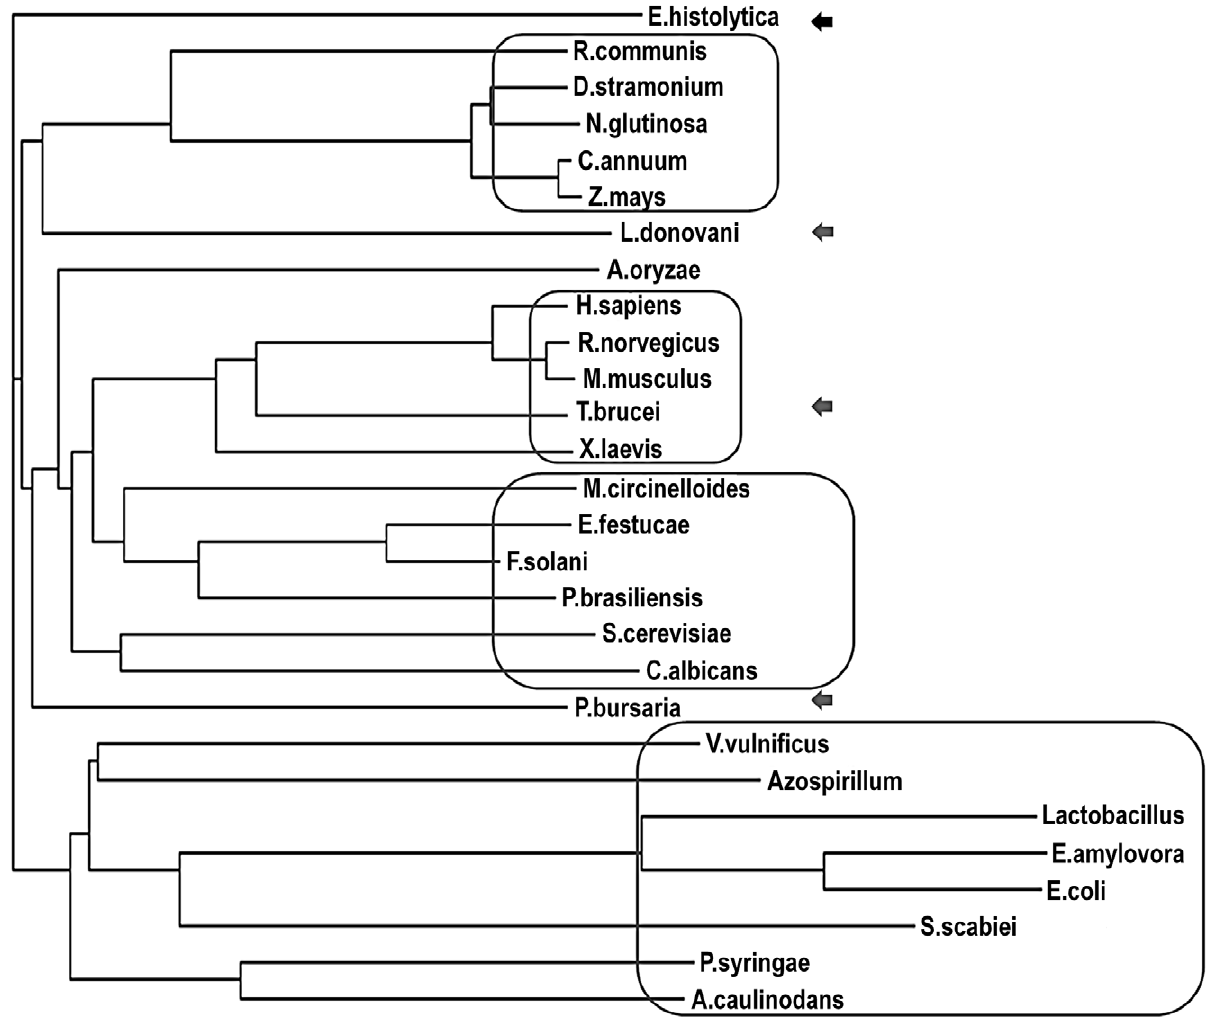
Figure 3. Phylogeny of ornithine decarboxylase from various sources. The amino acid sequences of ODC were taken from plants R. communis (XP_002510610.1), N. glutinosa (AAG45222.1), C. annum (AAL83709.1), Z. mays (AAM92262.1), D. stramonium (P50134.1); animals X. laevis (NP_001079692.1), R. norvegicus (NP_036747.1), M. musculus (P00860.2), H. sapiens (P11926.2); fungi A. oryzae (XP_001825149.2) M. circinelloides (CAB61758.1), E. festucae (ABM55741.1), P. brasiliensis (AAF34583.1), S. cerevisiae (EDN60096.1) F. solani (ABC47117.1), C. albicans (AAC49877.1); protozoa P. bursaria (NP_048554.1), T. brucei (P07805.2), L. donovani (P27116.1), E. histolytica (AAX35675) and bacteria V. vulnificus (YP_004188159.1), A. caulinodans (YP_001523249.1), P. syringae (AAO58018.1), E. amylovora (YP_003539917.1), S. scabiei (YP_003491041.1), Azospirillum (BAI72082.1), E. coli (BAE77028.1), Lactobacillus (P43099.2). Different clusters representing a particular group are highlighted in boxes where as the representatives of protozoa ODC are highlighted by arrow marks.